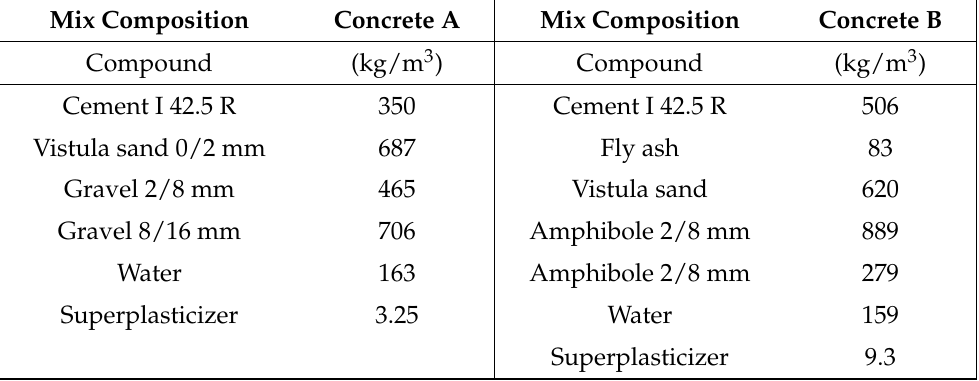
Table 2. Mix compositions.